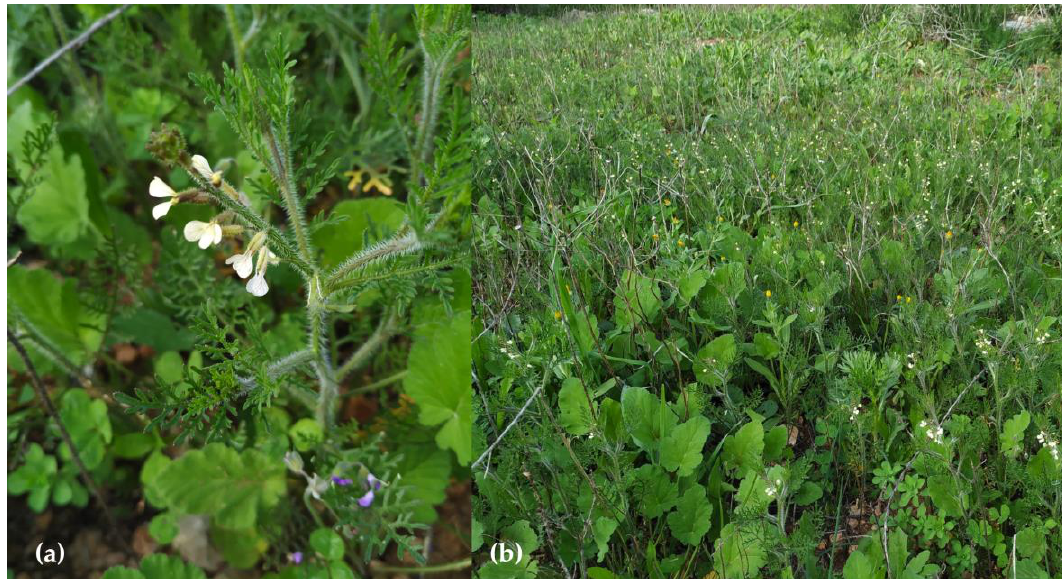
Figure 1. ( a ) Specimens of Carrichtera annua (L.) DC. identified during spring 2019 and photographed in 2020 in the town of Cerro da Á guia, in Albufeira, by Mauro Raposo, researcher at the Mediterranean Institute for Agriculture, Environment and Development (MED). ( b ) Group of plants of different species, with emphasis on the specimens of Carrichtera annua (L.) DC.